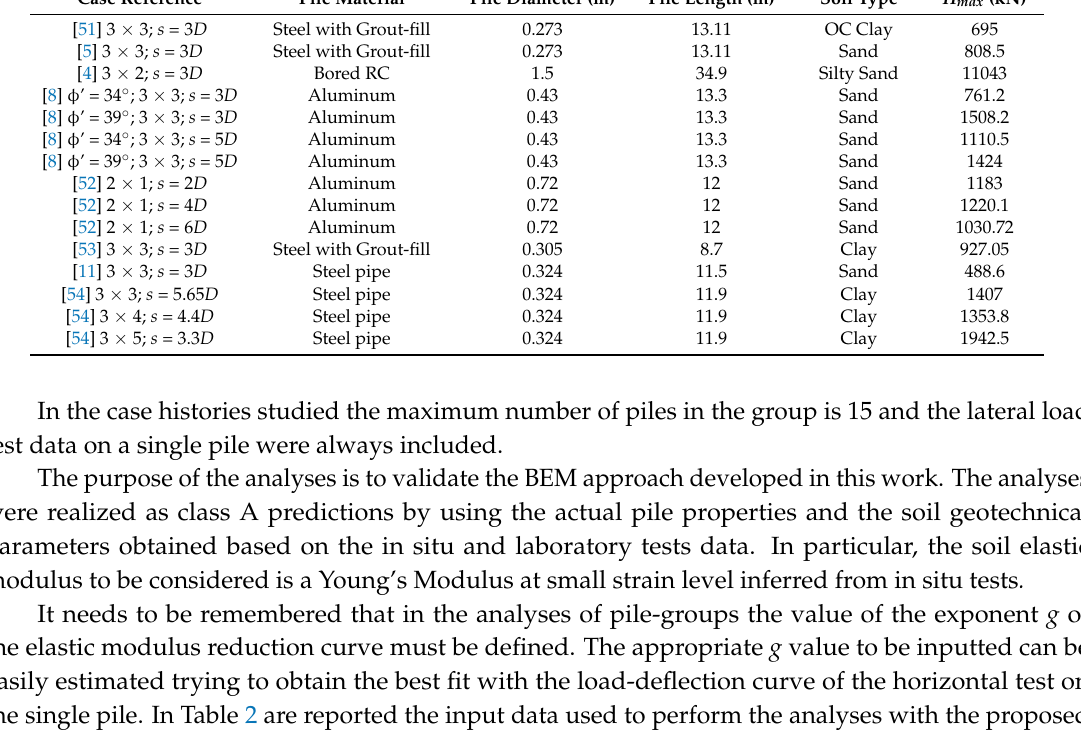
Table 2. Input data used to perform the analyses with the proposed method.